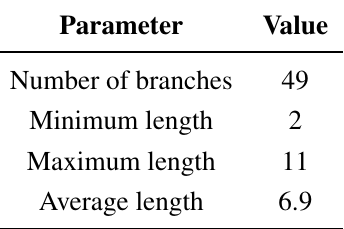
Table 2. Property of branches for the network with 121